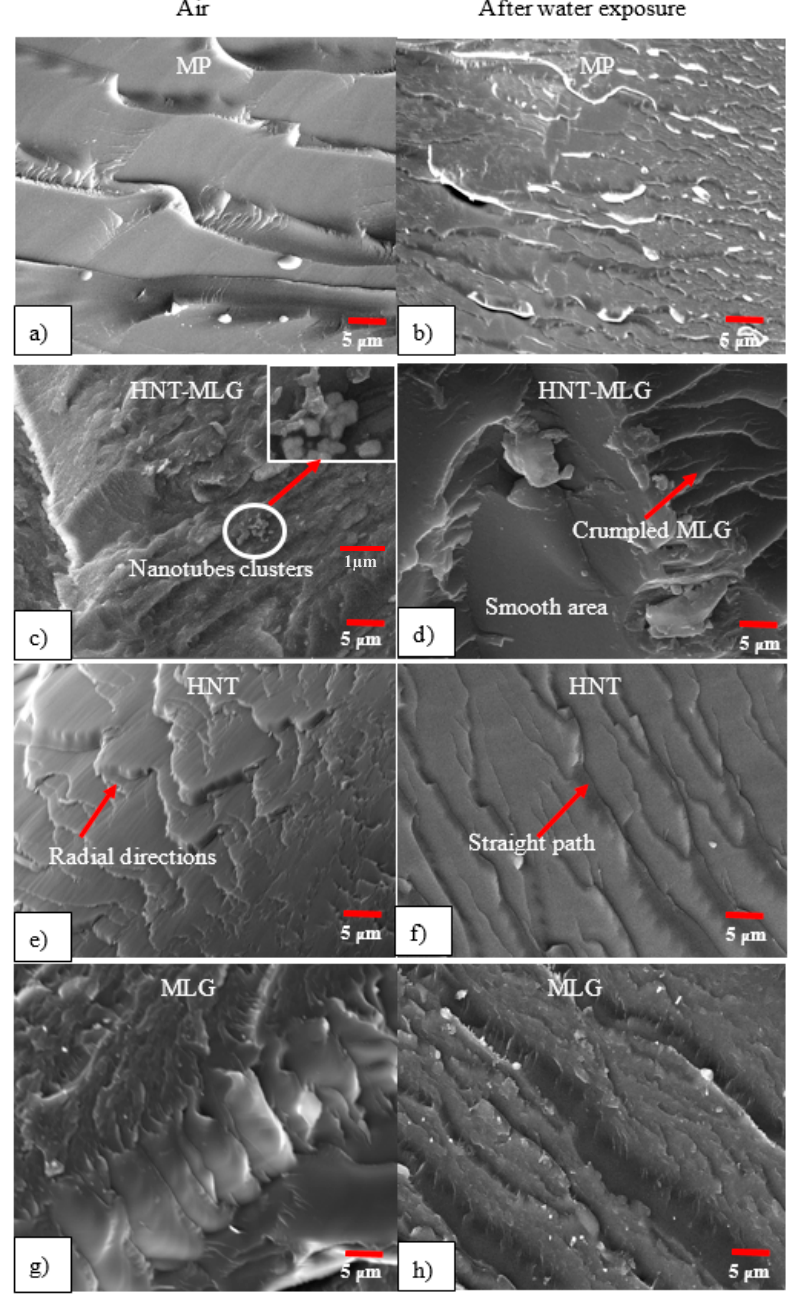
Figure 11. SEM images of nanocomposites before and after water exposure: ( a ) monolithic polyester before water exposure; ( b ) monolithic polyester after water exposure; ( c ) HNT-MLG nanocomposites before water exposure; ( d ) HNT-MLG nanocomposites after water exposure; ( e ) HNT nanocomposites before water exposure; ( f ) HNT nanocomposites after water exposure; ( g ) MLG nanocomposites before water exposure; ( h ) MLG nanocomposites after water